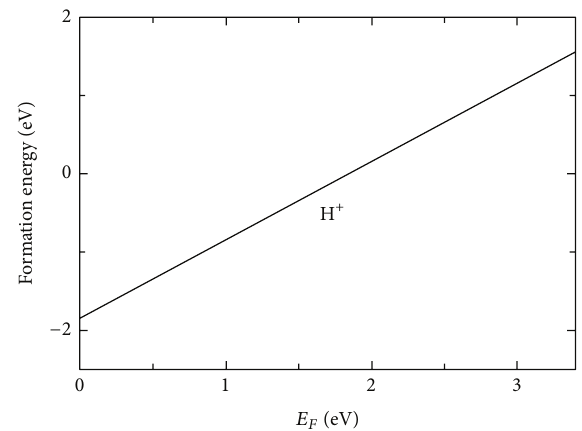
= 𝜇 ZnO + Δ𝐸 ZnO 𝑓 (low Zn